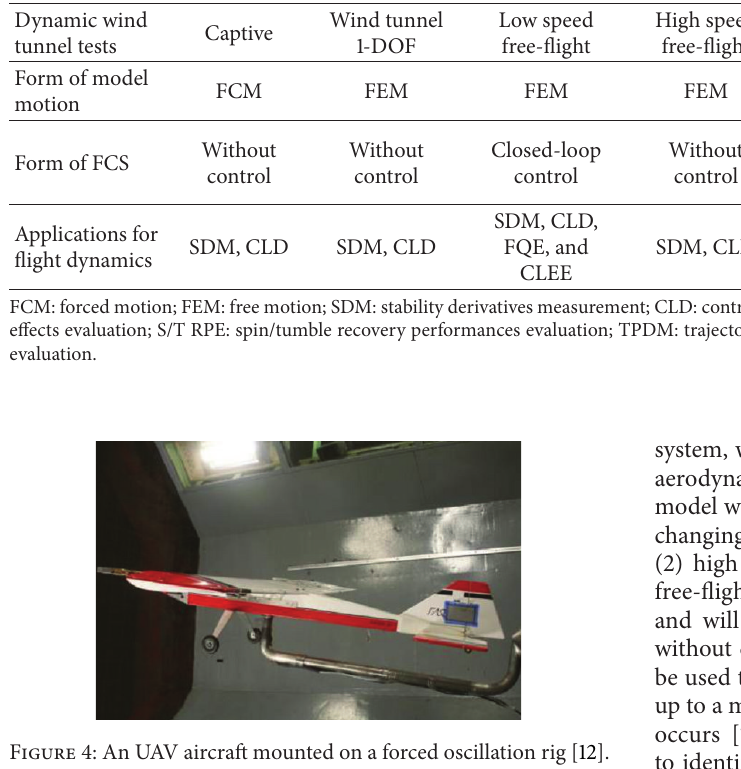
Table 1: Comparisons between VFT and traditional dynamic wind tunnel tests.